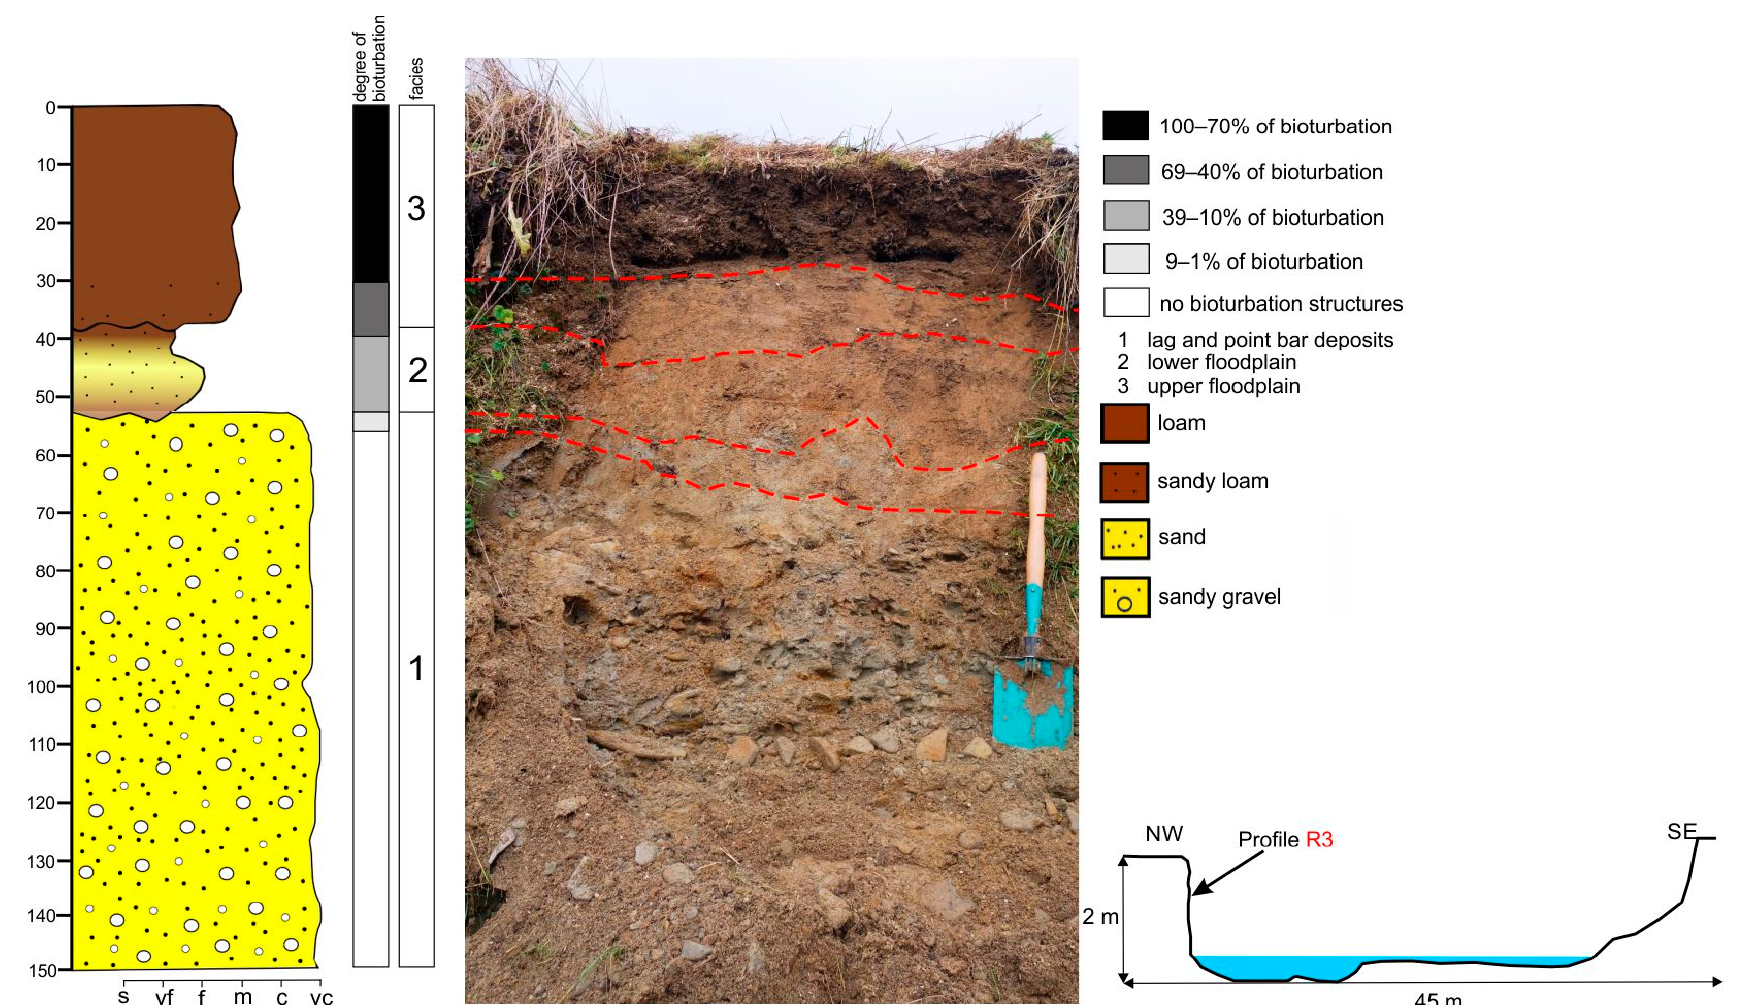
Figure 4. Characteristic of the vertical profile R3 in the Rogo ź nik Stream—sediment features and degree of recent bioturbation.